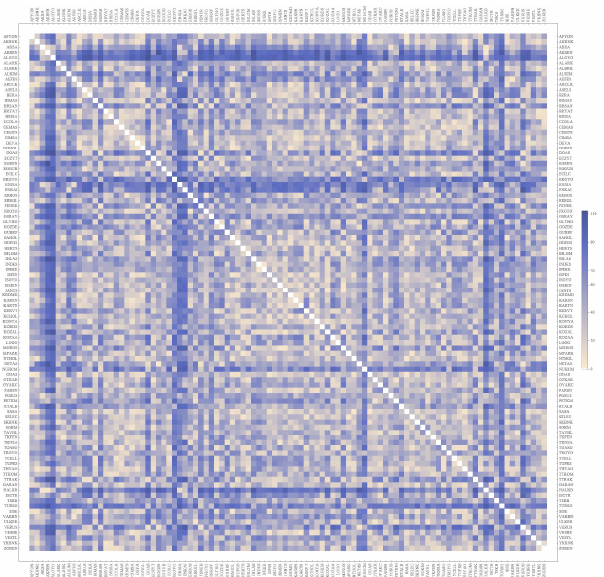
Figure 1. Intra-sectorial similarities of fractal dimensions measured by DTW (during pandemic).